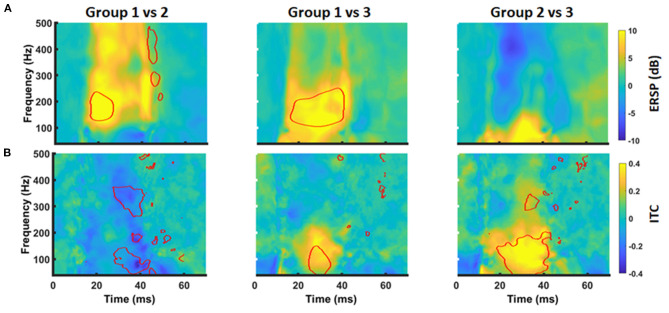
Group differences of time-frequency MEP behavior. Group differences in ERSP (A) and ITC (B) between Group 1 and 2 (left column), Group1 and 3 (middle column), and Group 2 and 3 (right column) were evaluated by cluster-based permutation analysis. Significant time-frequency bins are outlined in red (p < 0.05, cluster corrected).